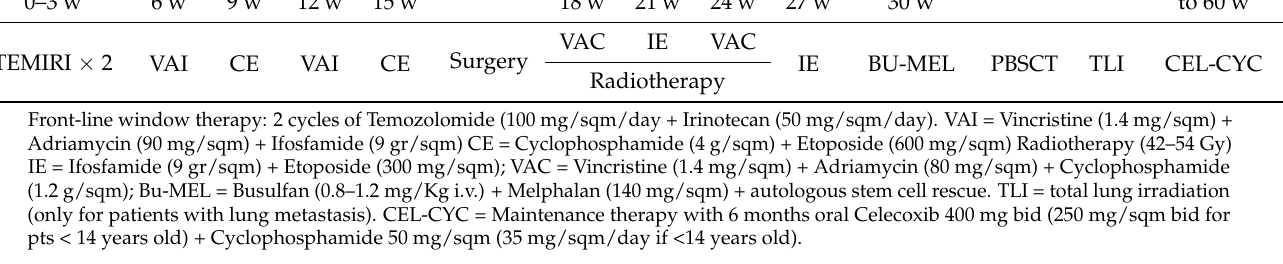
Table 1. Treatment program for patients with PDMES (ISG/AIEOP EW-2 Vers. 1.02). ISG/AIEOP EW-2, Vers 1.02